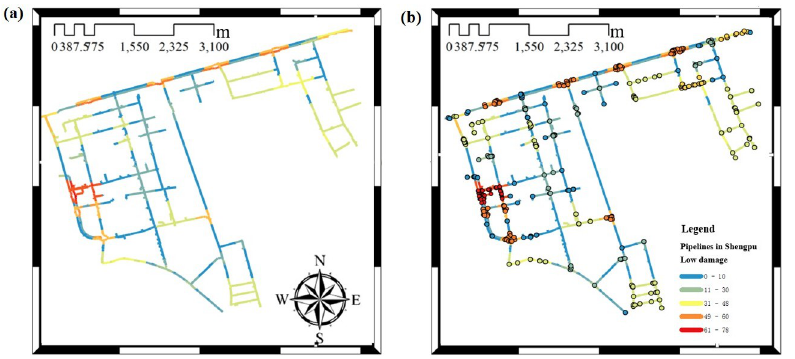
Fig 16. Low damage results from the connectivity to the water supply pipeline network in Shengpu subregion considering the nodes. (a) Considering the nodes, (b) Considering the nodes (including the nodes). (Republished under a CC BY license, with permission from Suzhou Industrial Park Qingyuan Huayan Water Co. LTD, original copyright 2019).